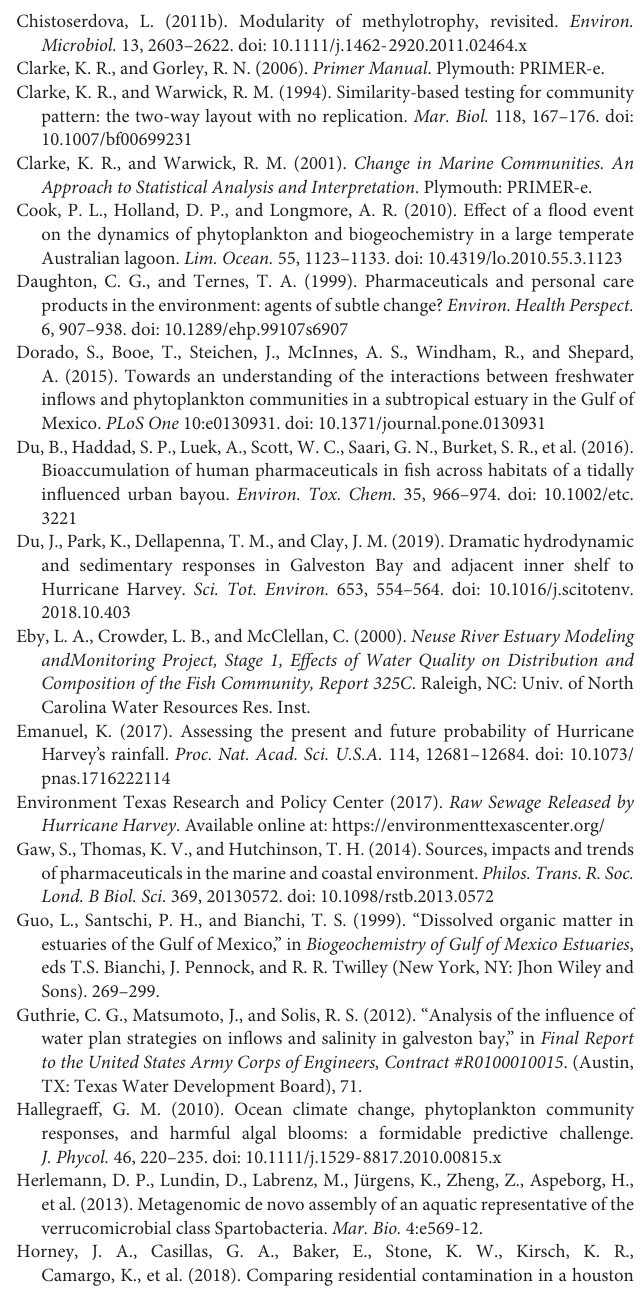
FIGURE S5 | PCA of the PAHs and PBs with base environmental variables shown as vectors. Stations are shown as differing symbols: Station 1 (closed upward triangle), 2 (closed downward triangle), 3 (closed square), 4 (closed diamond), 5 (closed circle), 6 (open upward triangle), 7 (open downward triangle), 8 (open square), 9 (open diamond), 10 (open circle). Time points are differentiated by color T1 (red), T2 (orange, T3 (green), T4 (blue), and T5 (purple). Environmental data were square root transformed and normalized then used to calculate the Euclidean matrix and construct the PCA. TABLE S1 | Non-significant results of the PERMANOVA analysis that was run on biological data matrix with the environmental data as the predictor variables. There were 9999 permutations ran to achieve the